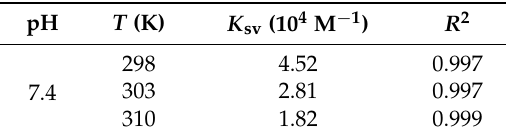
Figure 4. The modified Stern-Volmer plots used to obtain association constant of Dp44mT at different temperatures as previously described [16]. Conditions: [HSA] = 1.5 × 10 − 5 , pH = 7.4. Table 2. Modified Stern-Volmer association constant ( K a ) deduced from Figure 4 [16]. λ ex = 295 nm, λ em = 300–450 nm.